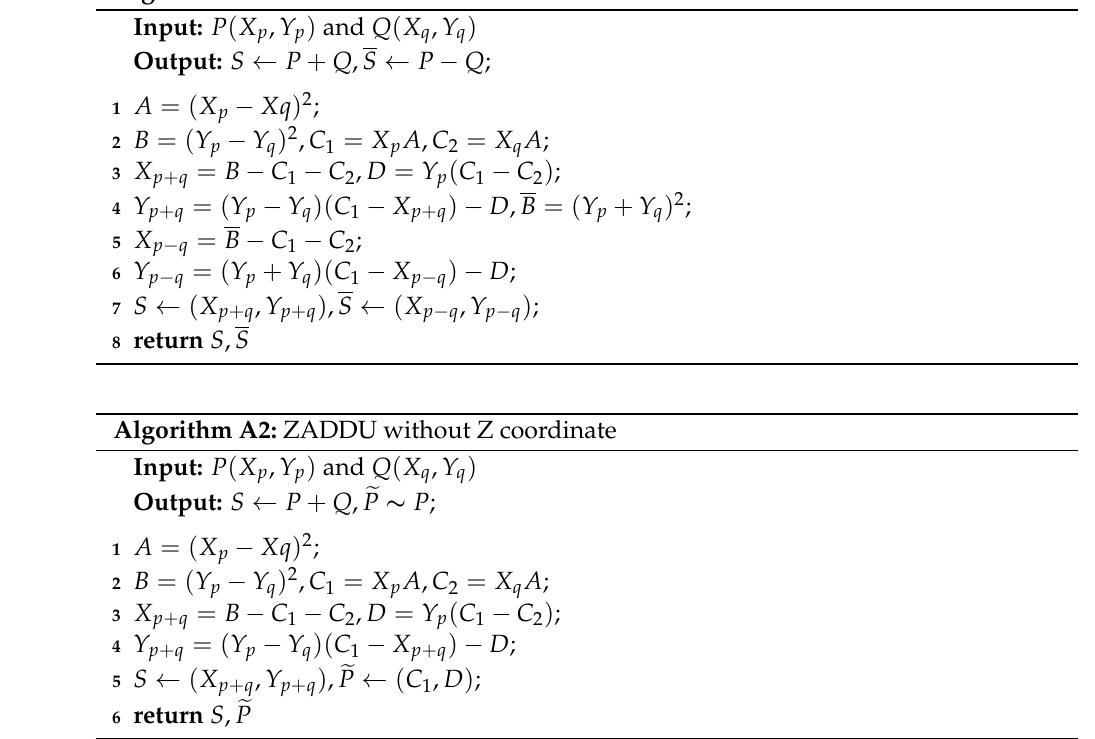
Algorithm A1: ZADDC without Z coordinate